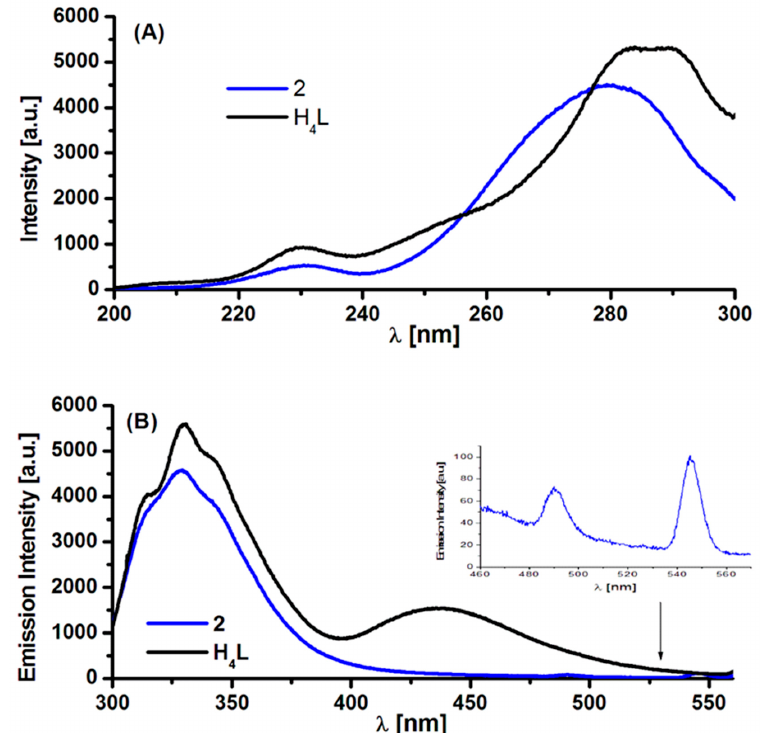
Figure 5. The excitation ( A ) and emission ( B ) spectra of methanolic solutions of H 4 L ligand and complex 2 , the inset presents the f-f transitions in the Tb III ion.